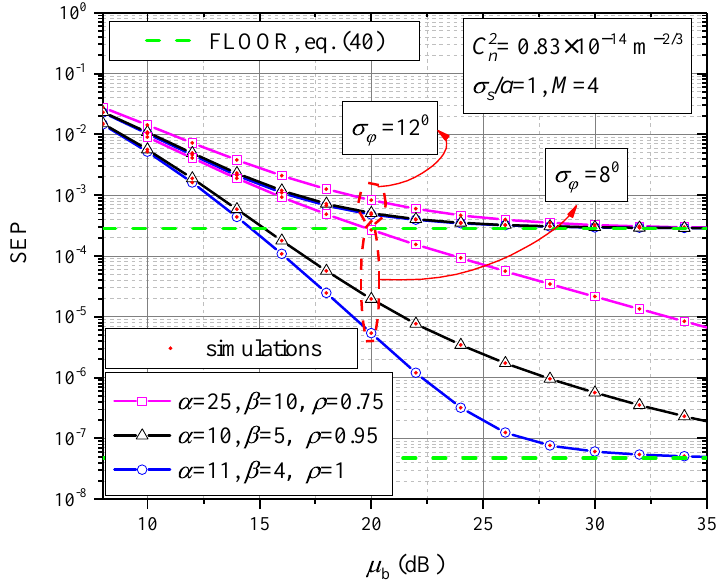
Figure 2. Average SEP vs. average SNR per